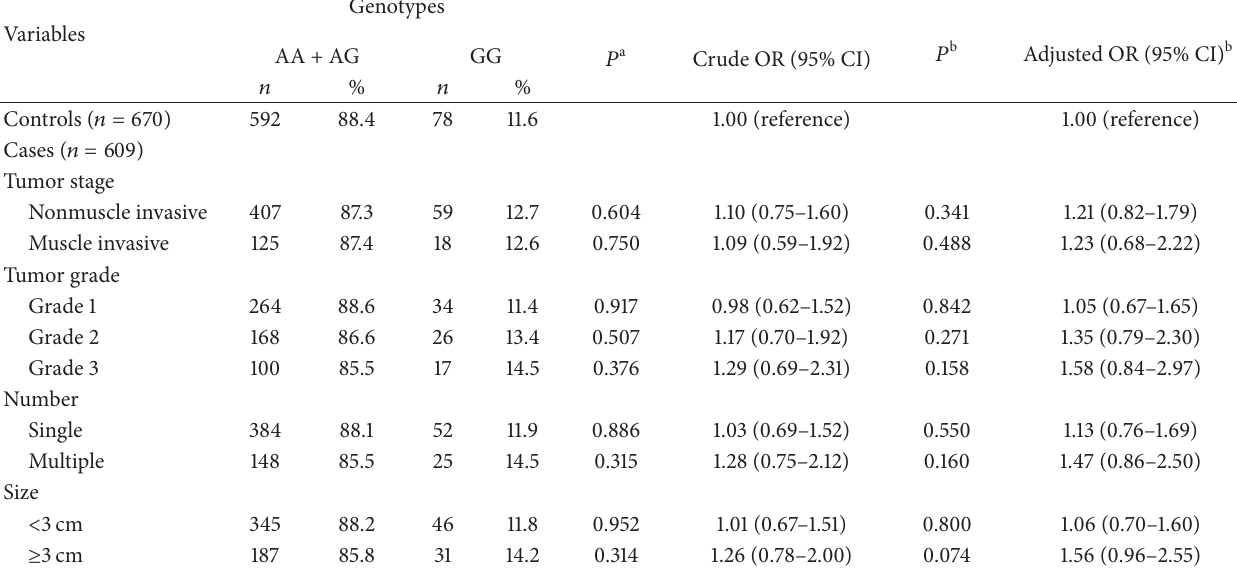
Table 4: The associations between TSP-1 -1223 A/G polymorphism and the development of bladder cancer.